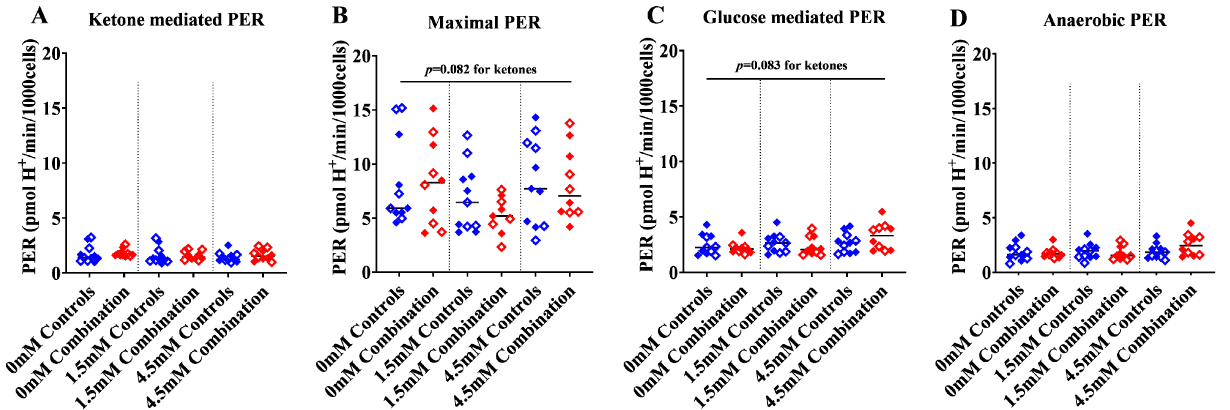
Figure 4. Maximal and glucose mediated total proton efflux rate (PER) tended to increase with increasing concentrations of β HOB. ( A ) Ketone mediated PER total , ( B ) Maximal PER total , ( C ) Glucose mediated PER total , and ( D ) Anaerobic PER total in control and combination exposed NRCM. Bars represent mean PER (n = 10–11 litter per group). Blue color indicates controls and red color indicates combination exposed. Open symbols in the graph indicate males and filled symbols indicate females. Ketone mediated effect was determined by two-way ANOVA with p values as shown. mM refers to the progressive concentration of β HOB supplied.